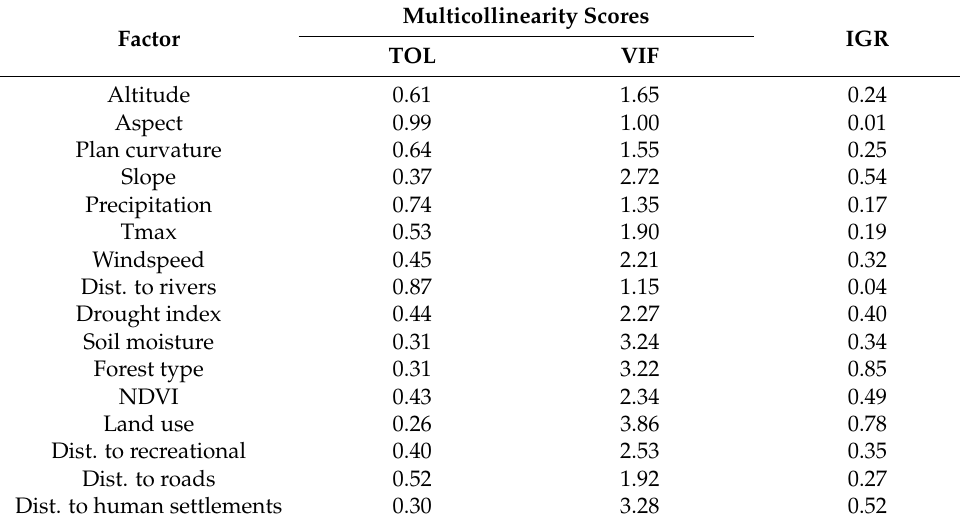
Table 3. TOL, VIF, and IGR scores of wildfire-driving